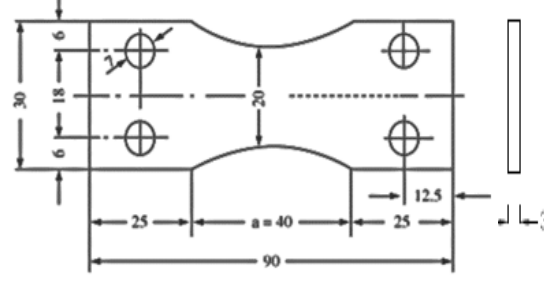
Fig. 4. Standard Fatigue Test Sample with thickness of 3mm all dim. in mm for plane sample [Avery